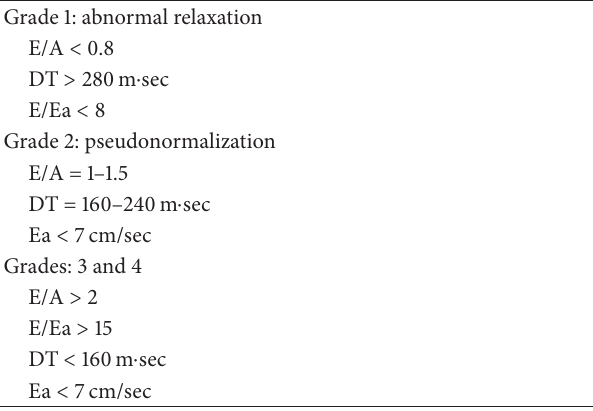
Table 1: Diastolic dysfunction grades.